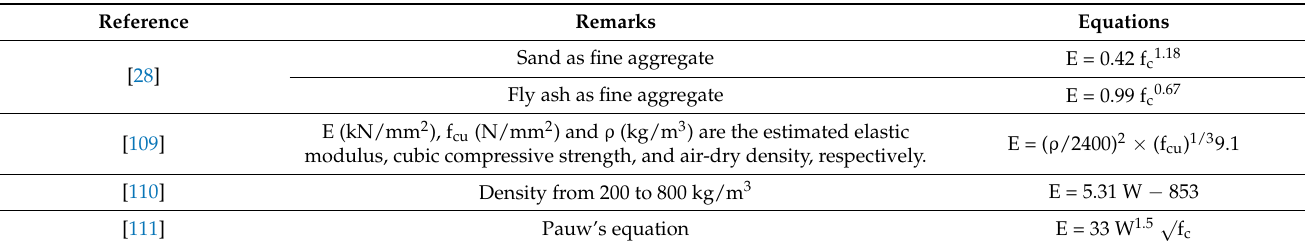
Table 11. Equations used for elastic